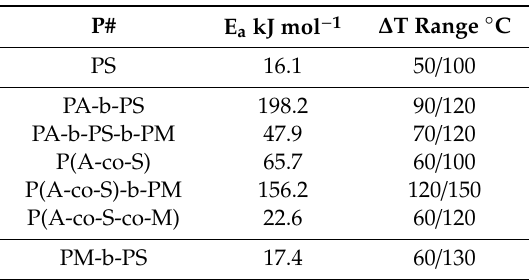
Figure 9. Arrhenius plots (in log 10 scale) of the DC conductivity, σ dc , calculated for polymers containing AMPS polar groups. Table 4. Activation energies, E a , of the direct current conductivity values, σ dc , obtained from the Arrhenius plots in Figure 9, and the corresponding temperature linear regions.